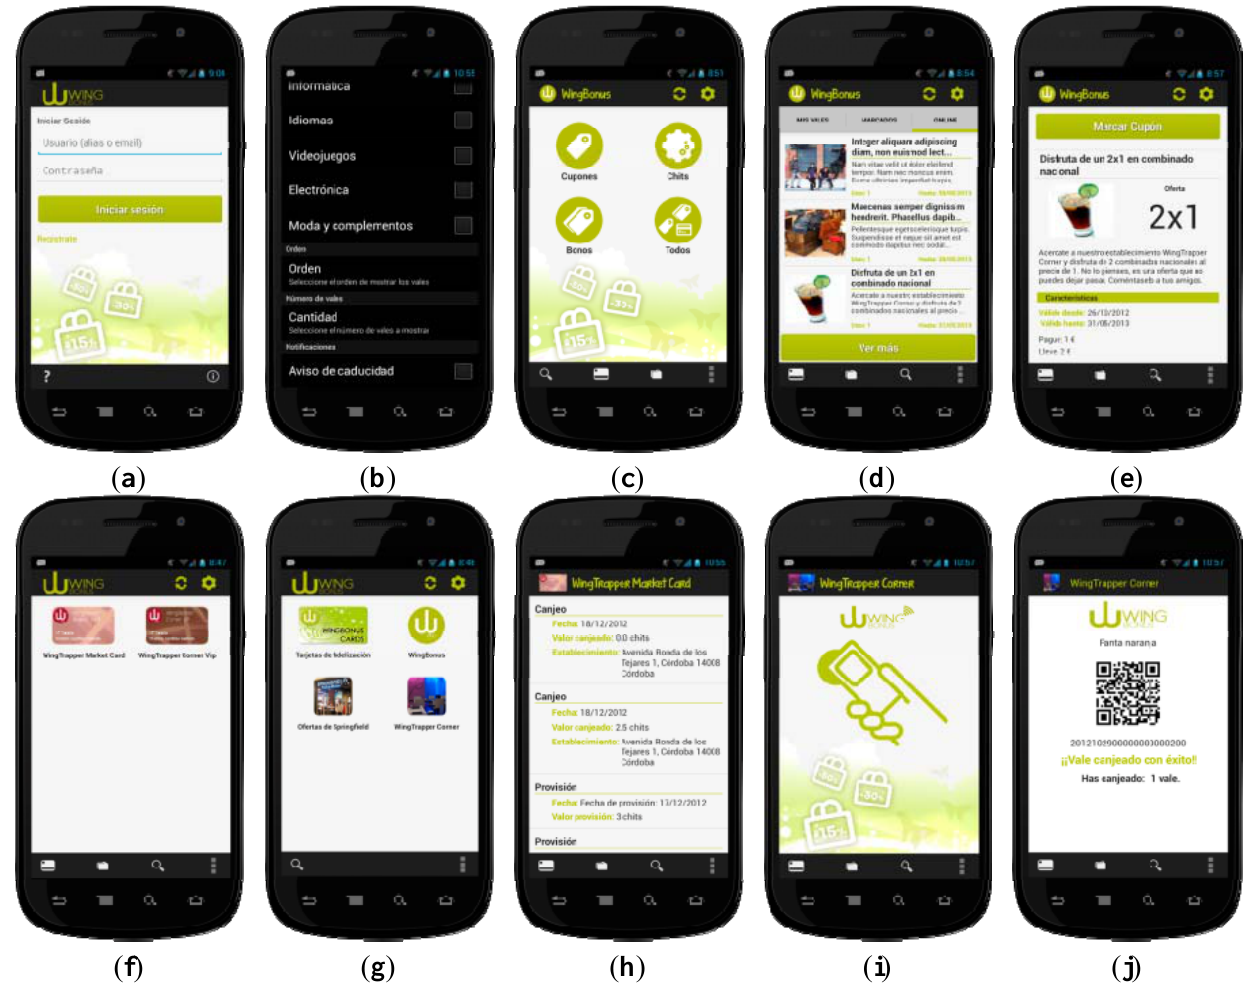
Figure 5. Some WingBonus mobile application